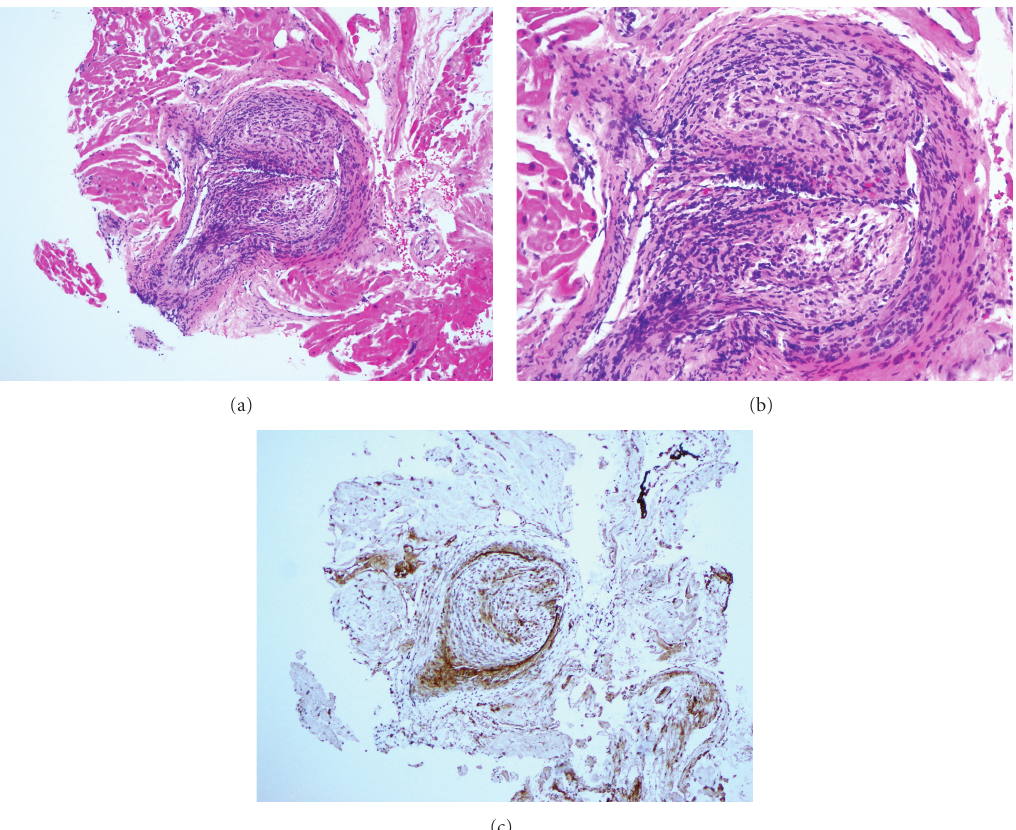
Figure 1: Endomyocardial biopsy 7 months after transplant showing graft vasculopathy. Endomyocardial biopsy demonstrating microscopic changes of concentric intimal proliferation and chronic inflammation resulting in near-total luminal occlusion in the epicardial and the intramyocardial coronary vessels, suggestive of graft vasculopathy. Hematoxylin and eosin stain: (a) low power, (b) high power, and (c) C4d immunostaining. Immunoperoxidase with C4d monoclonal antibody